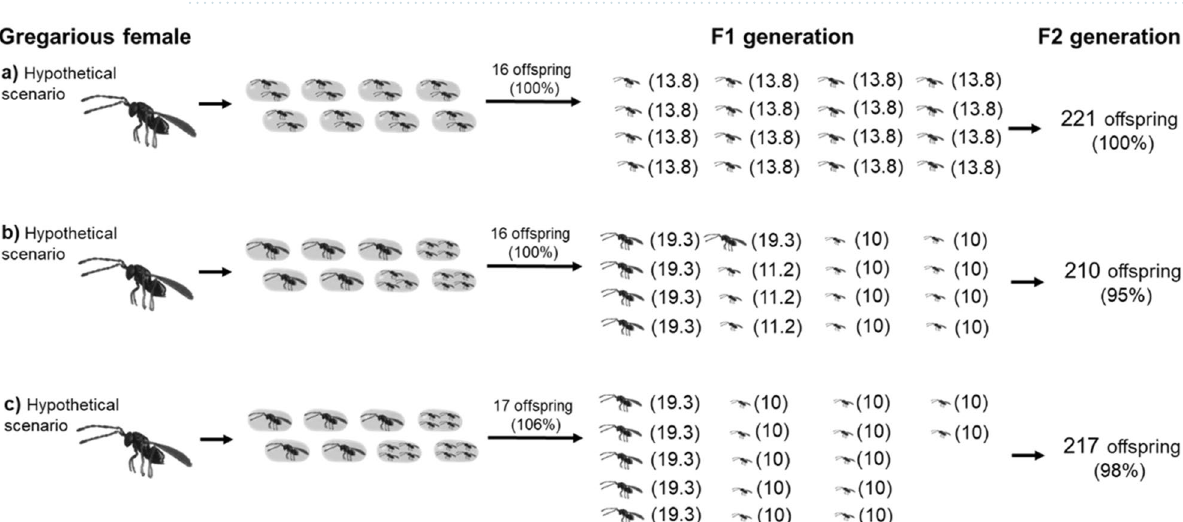
Figure 1. The different fertilities obtained in the F2 generation for solitary and gregarious parasitoids with different numbers of host eggs. *The fertility values shown in parentheses (explained in “Methods” section and Suppl. Mat. 3); The offspring sex ratio of solitary parasitoids is 1:1 (female:male; assuming random mating of individuals in the population 41 ), and the offspring sex ratio of gregarious parasitoids is female biased 3:1 (female:male; reviewed for our model species A. flavipes 38 ); females are shown as (left oriented) and males as (right oriented).